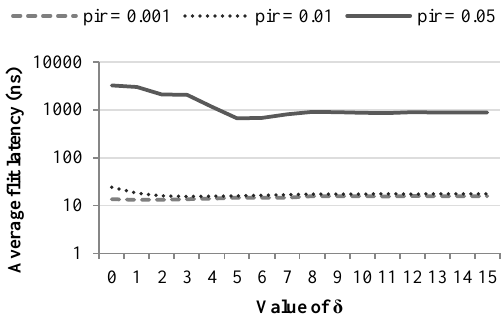
Figure 5. Effect of δ on the average flit delay for different values of PIR (6 wireless interfaces).